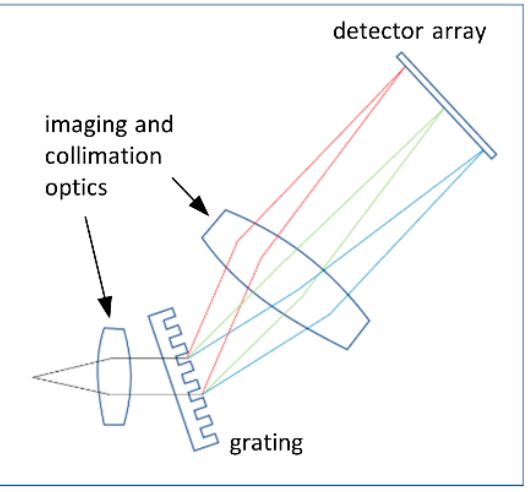
Figure 2. Schematic design of a transmission grating spectrometer with a symbolic grating shape. There are different options to miniaturize the sensors, and Micro-Electro-Mechanical Systems (MEMS) represent one miniaturization option that enables wavelength tuning.